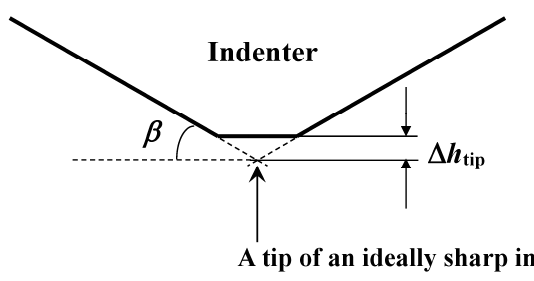
Figure A1. Schematic illustration of a truncated conical indenter tip.